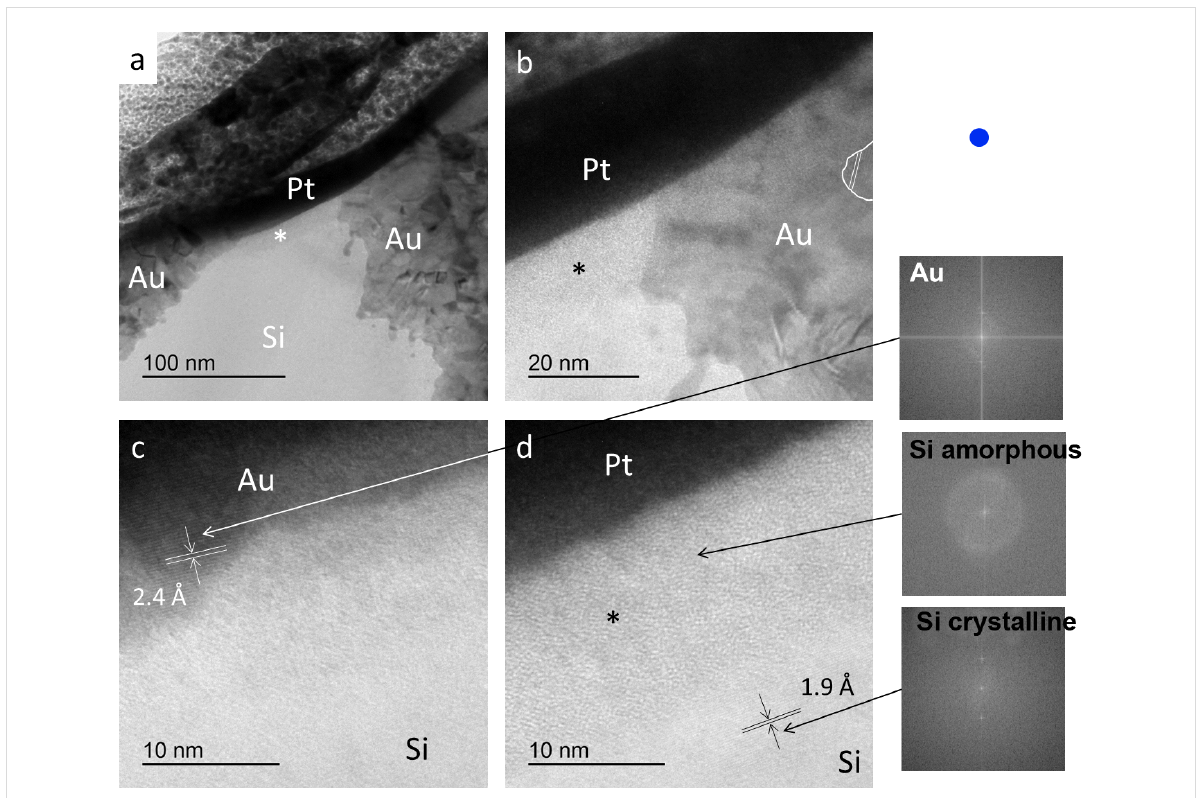
Figure 7: TEM images of a cross section through the apex of a Au/Si tip that had been sliding against Au(111). a) Overview showing the Pt protec- tive coating that was added prior to FIB cutting, the Au cantilever coating and the Si bulk. The contact area is worn flat and the asterisk marks an amorphous layer in the contact region. b) Detail of panel a) showing the amorphous Si with its sharp boundary to crystalline Si as well as crystallites (highlighted) in the Au layer. c) Close-up resolving the crystal lattice in the Au coating layer. The lattice distance was measured to be 2.4 Å. d) Detail of the amorphous layer (*) and the crystalline Si bulk with a lattice distance of 1.9 Å. Fourier transformations of the Au lattice in panel c) and the Si amorphous layer and the crystalline Si from panel d) are provided in the right part of the figure.